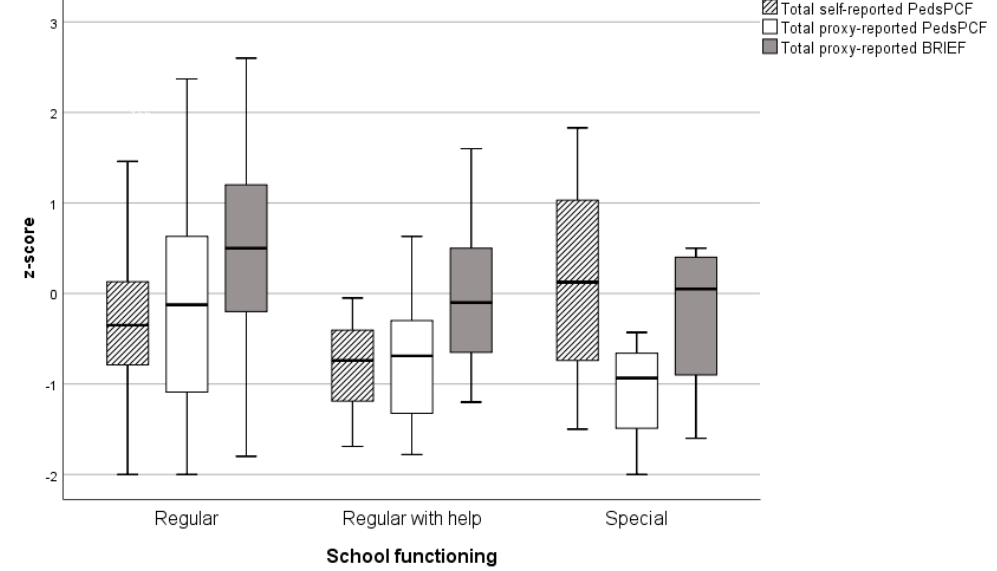
Figure 2. Total PedsPCF and BRIEF z-scores per level of school functioning. PedsPCF = pediatric perceived cognitive functioning, BRIEF = behavior rating inventory of executive function. Y -axis: levels of school functioning. Box-whisker plots represent the different questionnaires with the median, IQR, maximum and minimum scores (three positive outliers with total self-reported PedsPCF scores for children attending regular education are not shown).